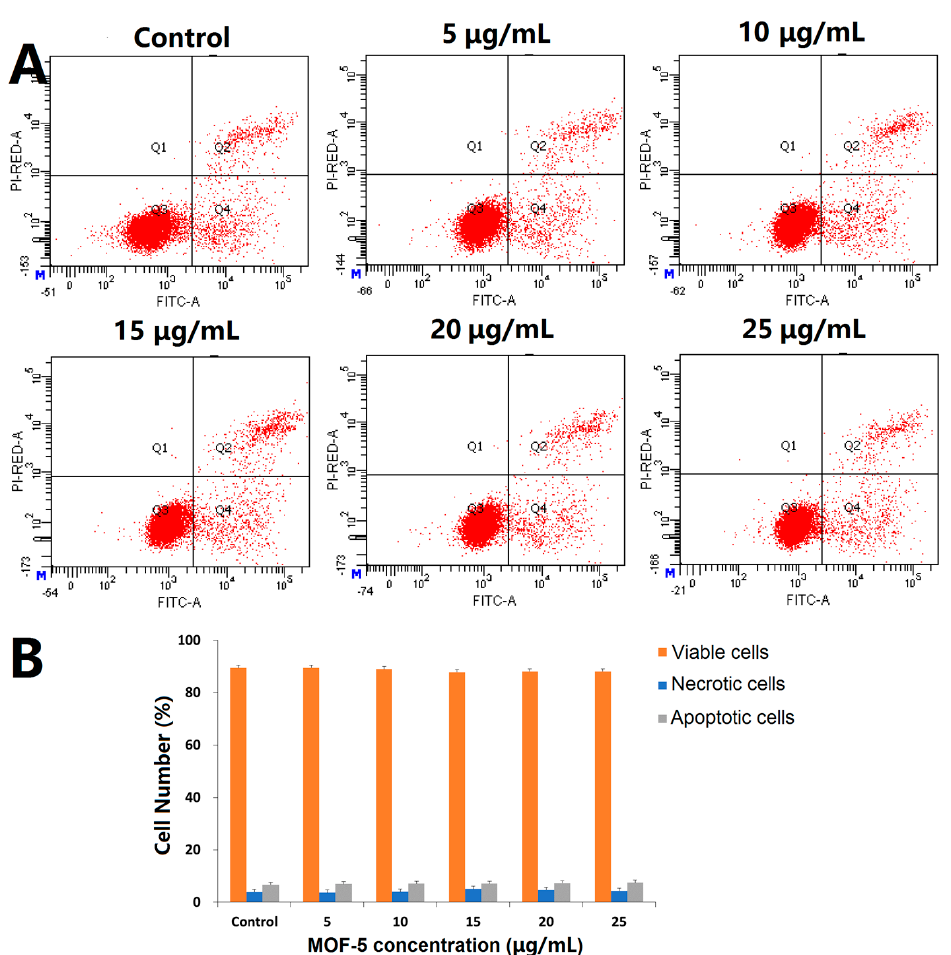
Figure 9. ( A ) Apoptosis assays for HepG2 cells after treatment with different concentrations of MOF-5 for 24 h; ( B ) Statistical analysis of cell apoptosis.